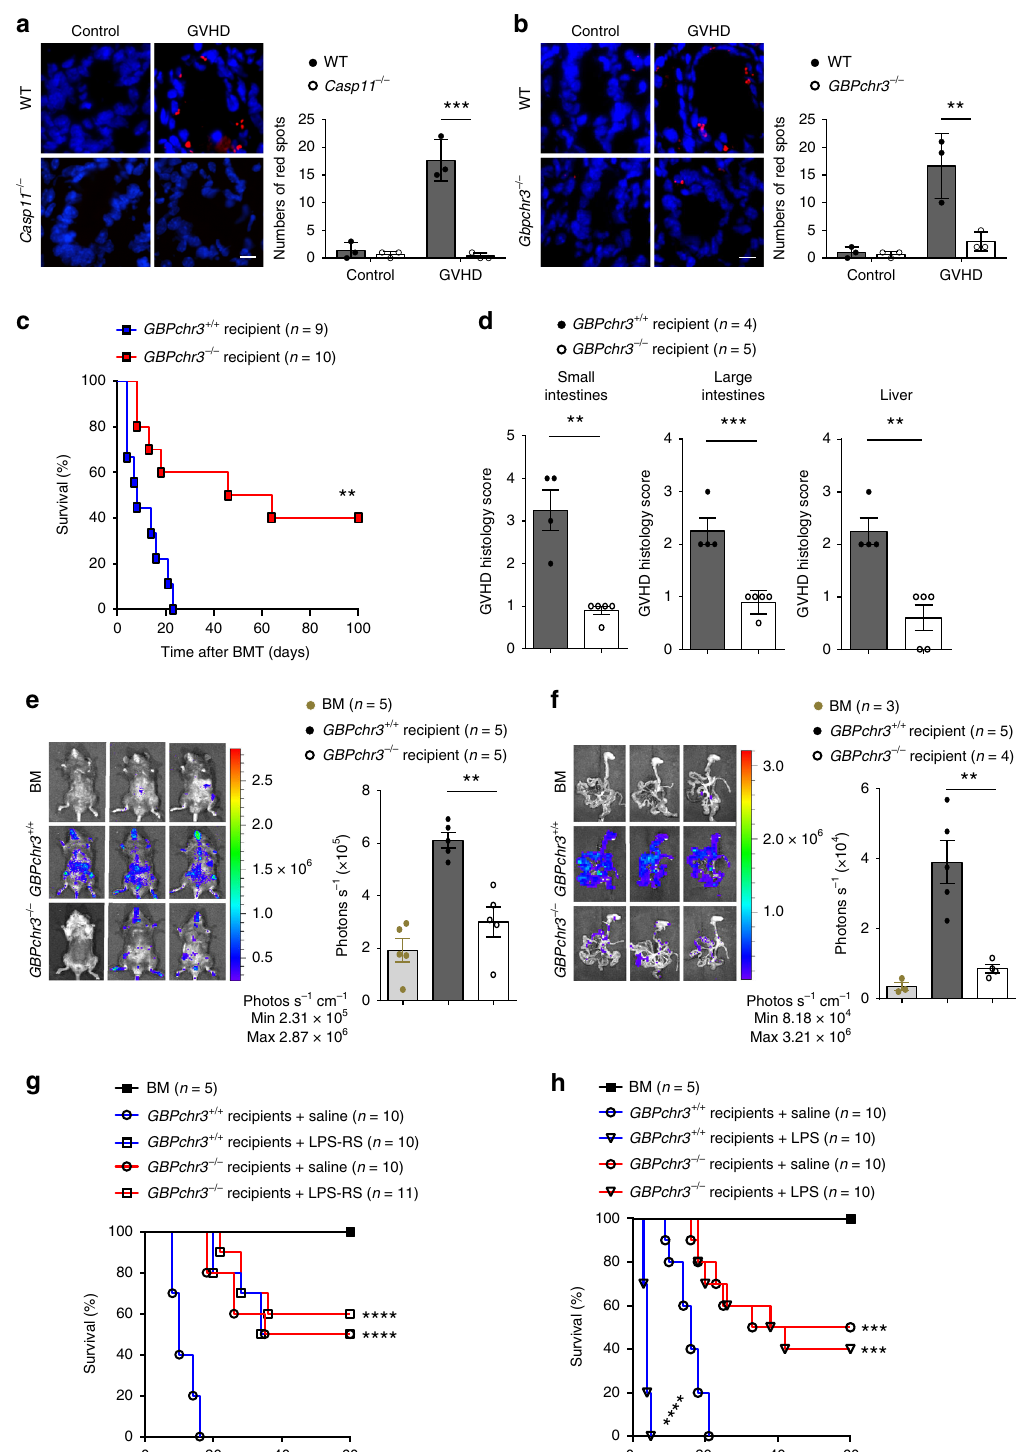
enhances GVHD through GSDMD in the MHC-mismatched allo-HSCT. Deletion of Gsdmd signi fi cantly improved survival (Fig. 4b), and markedly reduced serum IFN- γ levels (Supple- mentary Fig. 5a) and intestinal neutrophil in fi ltration (Supple- mentary Fig. 5b). Gsdmd de fi ciency signi fi cantly improved GVHD pathological scores in a manner similar to Caspase-11 de fi ciency (Fig. 4c and Supplementary Fig. 5c) and was associated with reduced T cell expansion as using